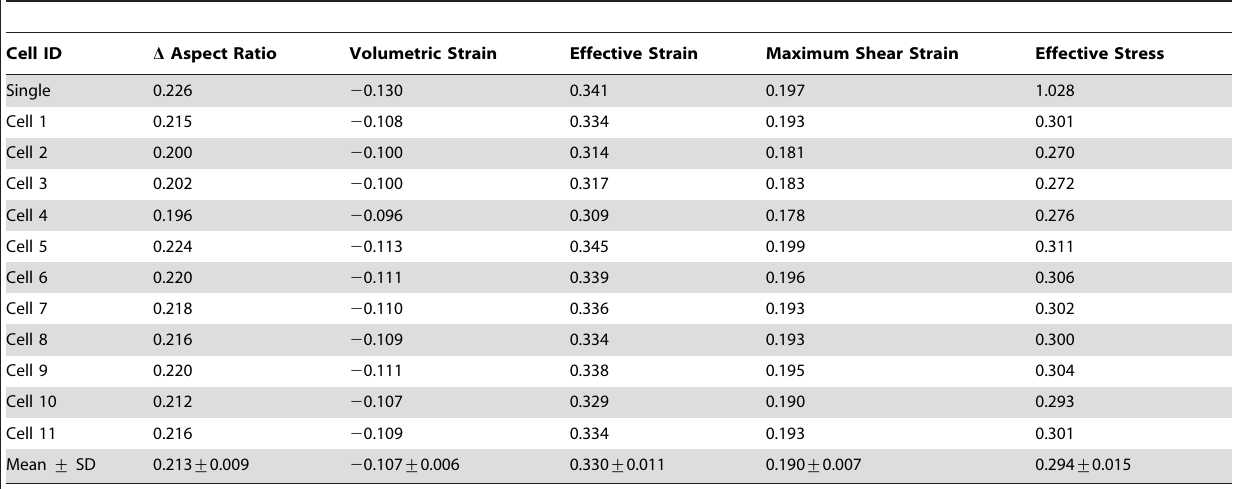
Table 4. Chondrocyte deformation metric set for a single and eleven cell model with boundary conditions prescribed via a specific deformation gradient passed from the macro-scale.